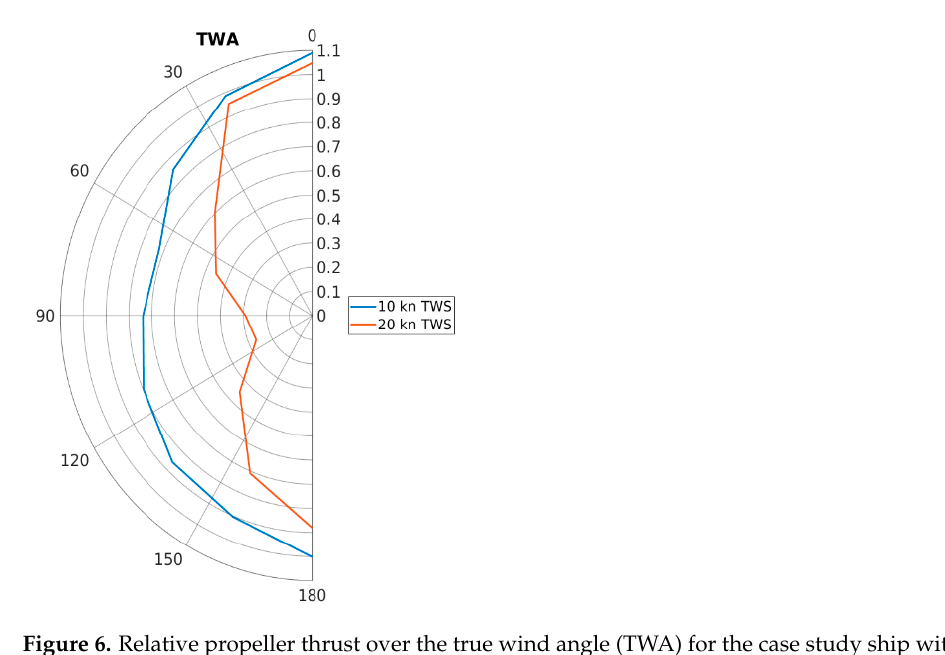
Figure 6. Relative propeller thrust over the true wind angle (TWA) for the case study ship with two Flettner rotors, ship speed = 16 kn.